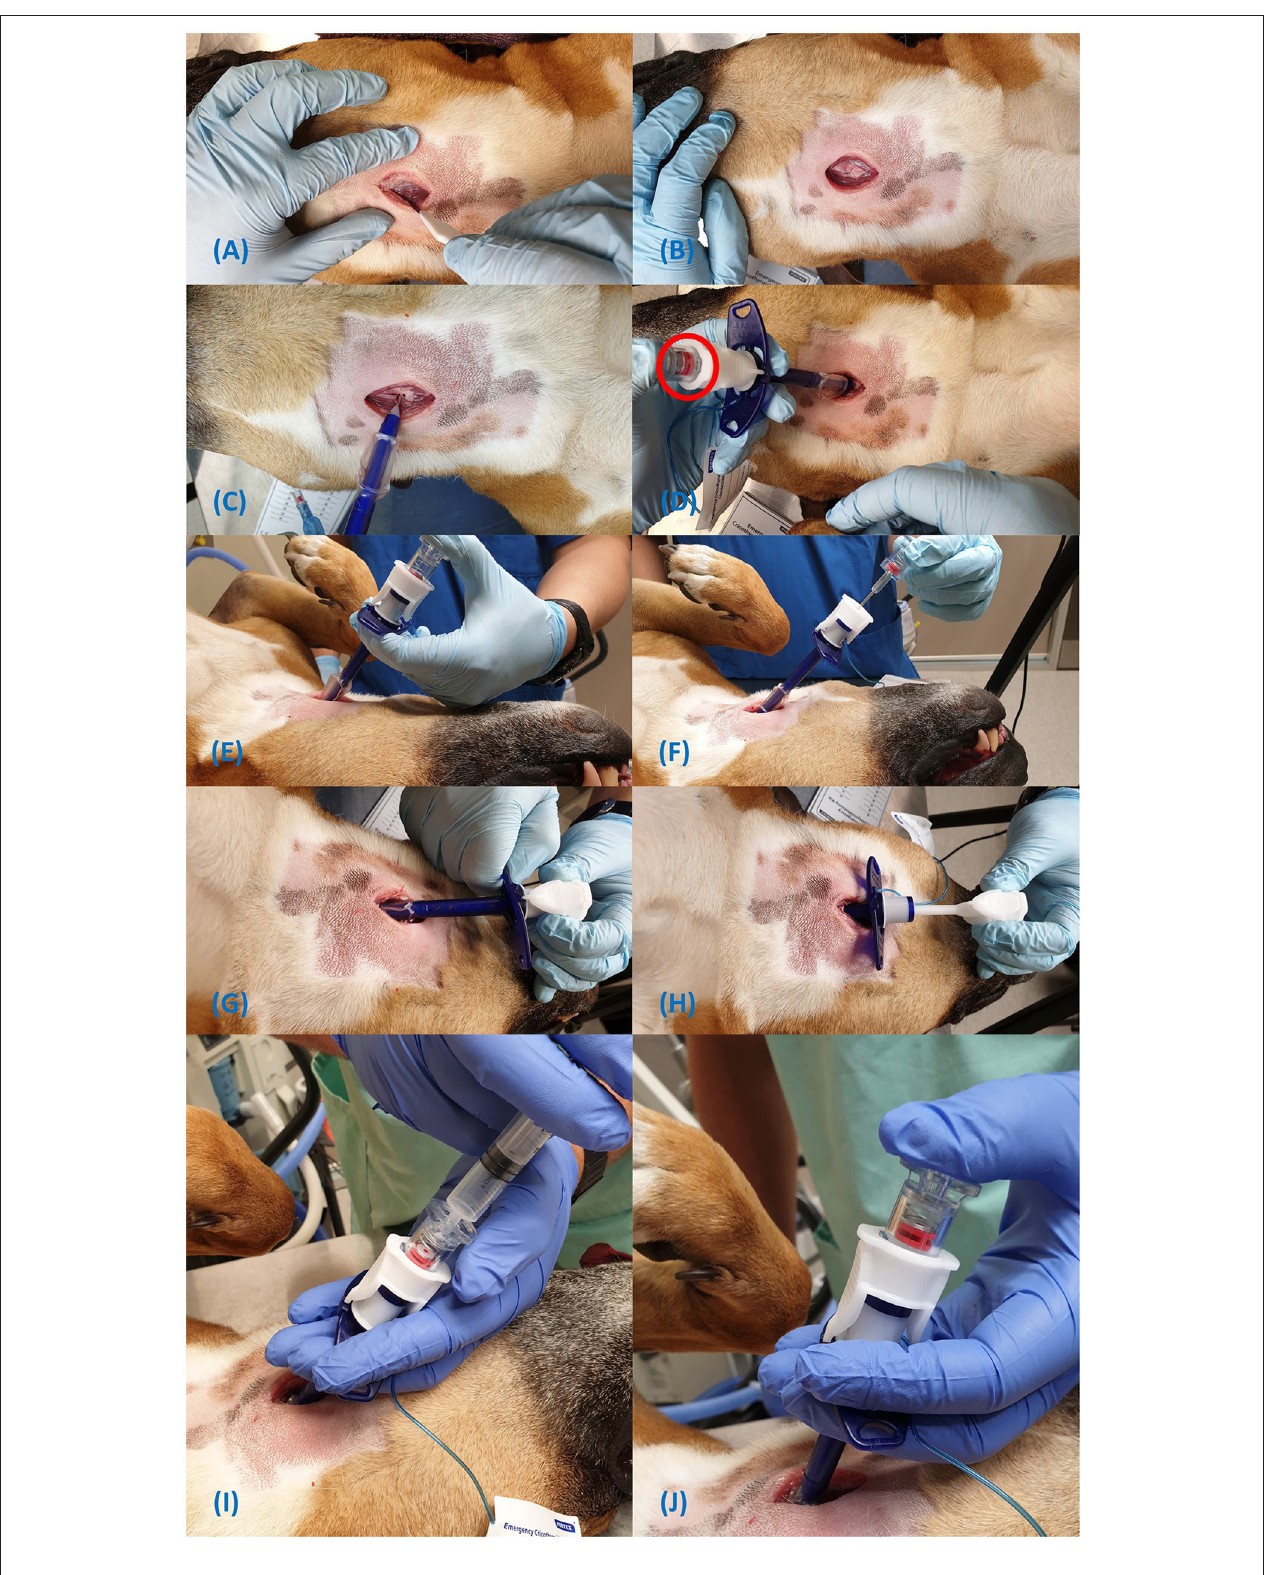
FIGURE 5 | Steps for insertion of the Portex® cricothyrotomy tube (A-J) .